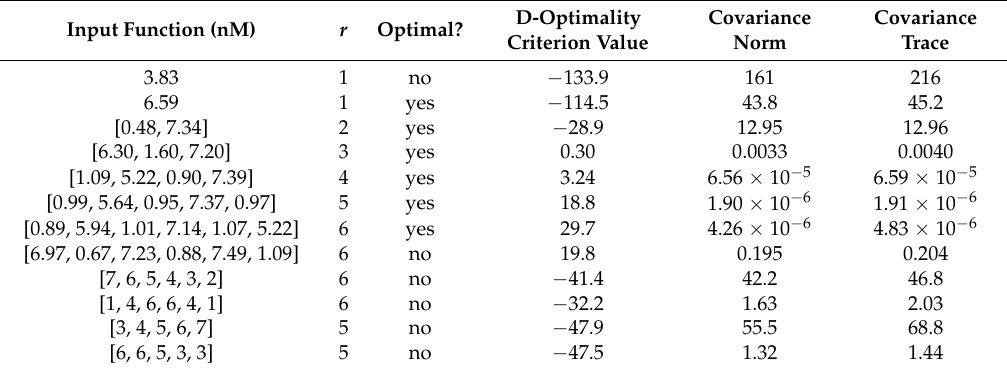
Table 1. Optimal and sub-optimal input functions for values of r from 1 to